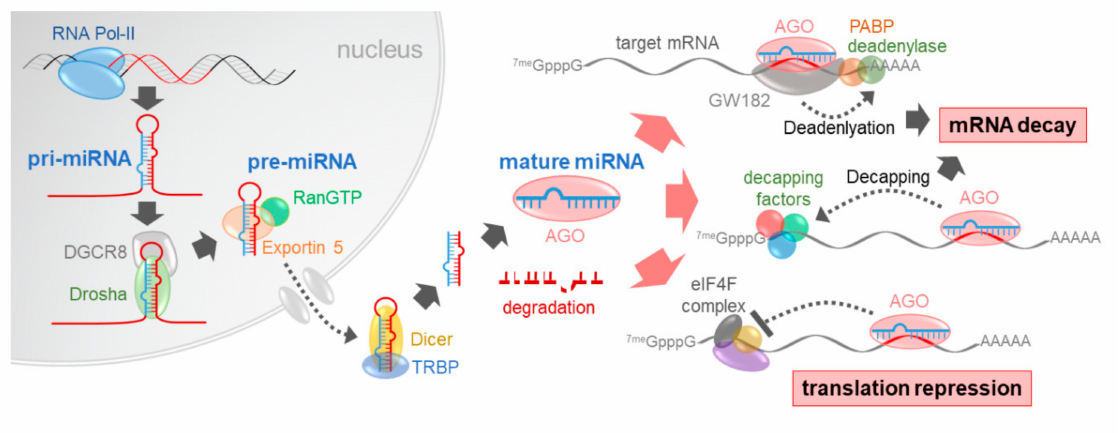
Figure 1. Biogenesis and functional mechanisms of